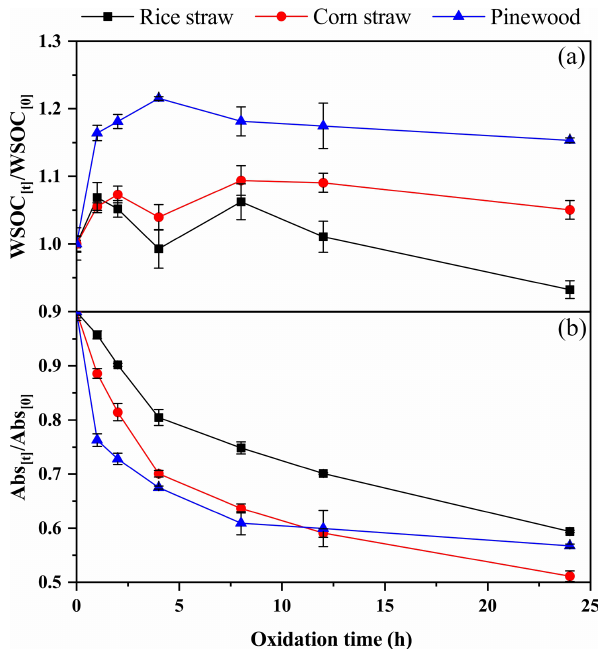
Figure 2. Dynamic variations of (a) WSOC content and (b) light absorption at a wavelength of 365nm by the BB BrC during the ozone aging